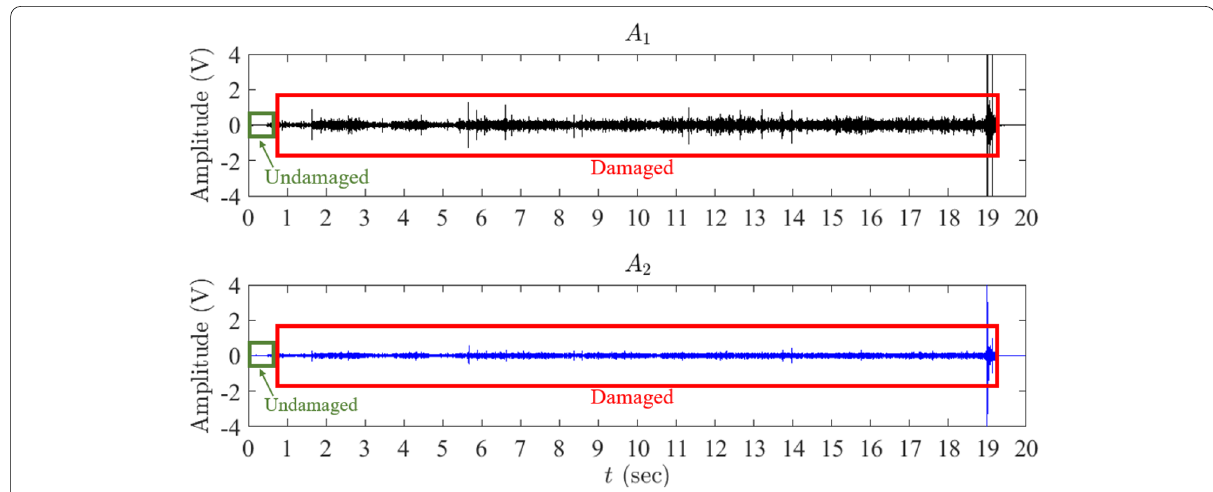
Fig. 18 Time history of the measured AE data collected using sensors A 1 and A 2 of damage at D